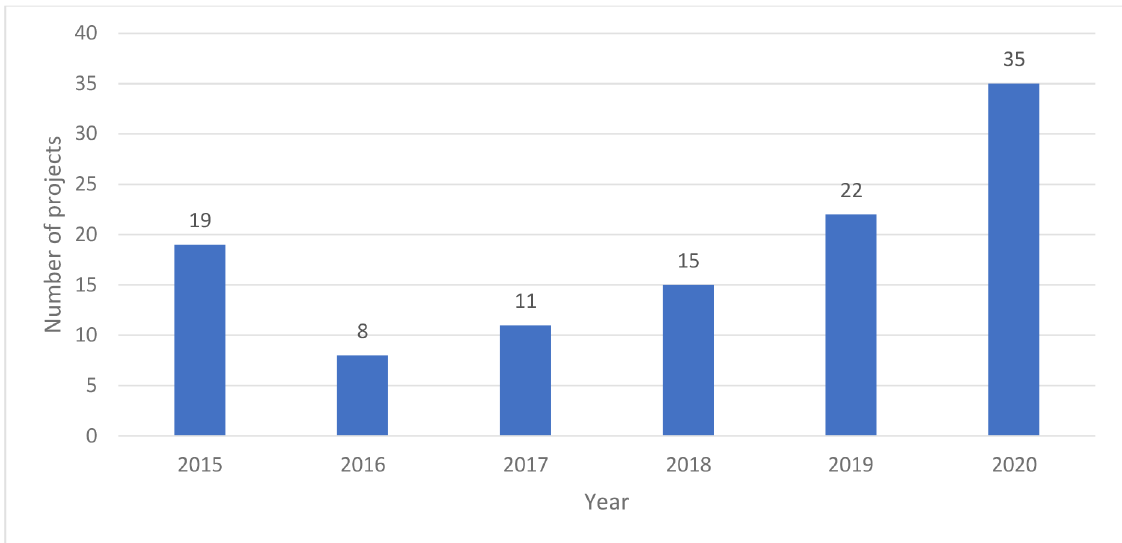
Figure 3: Number of cross-jurisdictional projects submitted to the PHRN online application system, by